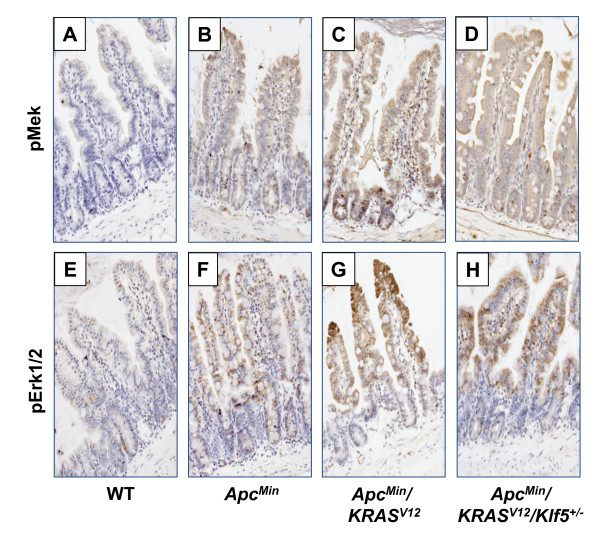
Phosphorylation of MEK and ERK in the normal-appearing small intestinal tissues of wild type and mutant mice. Immunohistochemical analyses were performed with phospho-Mek (pMek; A-D) and Phospho-Erk1/2 (pErk; E-H) antibodies. WT is wild type.